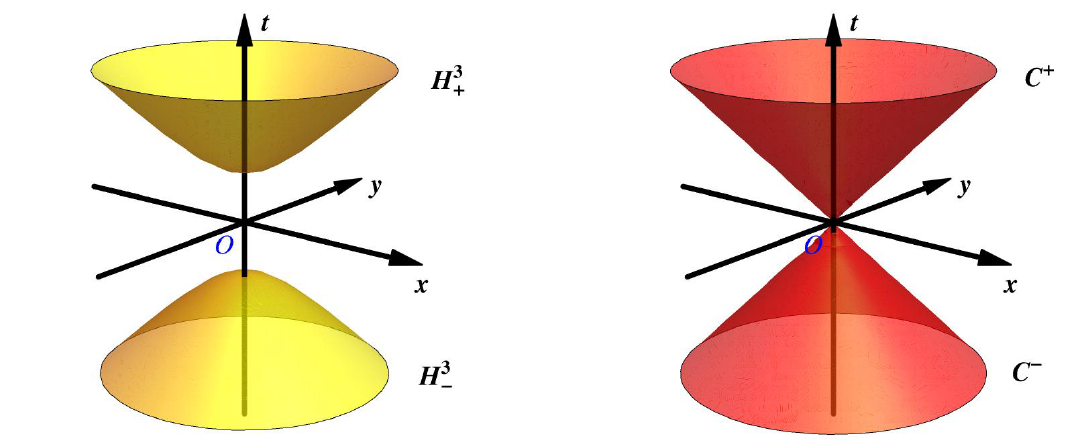
Figure 2 . Two distinguished hypersurfaces in Minkowski space from the perspective of a chosen observer at O . Left panel: the two-sheeted hyperboloid defined by x µ x panel: the lightcone defined via x µ x sectors of the light cone can be selected by choosing either x remark that the z -axis is suppressed to yield 3 d pictures and that the so-called skirt radius a of the hyperboloid is set to unity